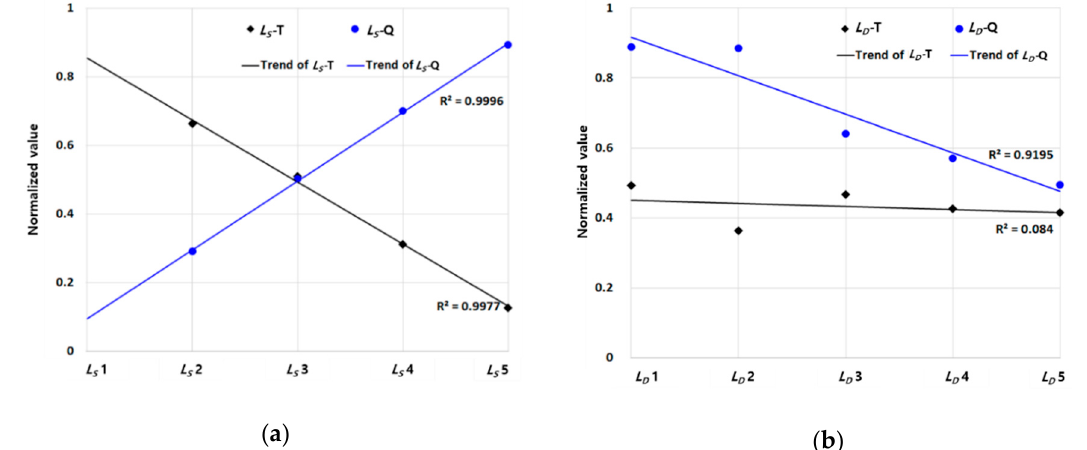
Figure 6. Relationships between L S and L D and working time and quality: ( a ) Relationship between working time ( L S -T) and work quality ( L S -Q) according to L S level; ( b ) relationship between working time ( L D -T) and work quality ( L D -Q) according to L D level.